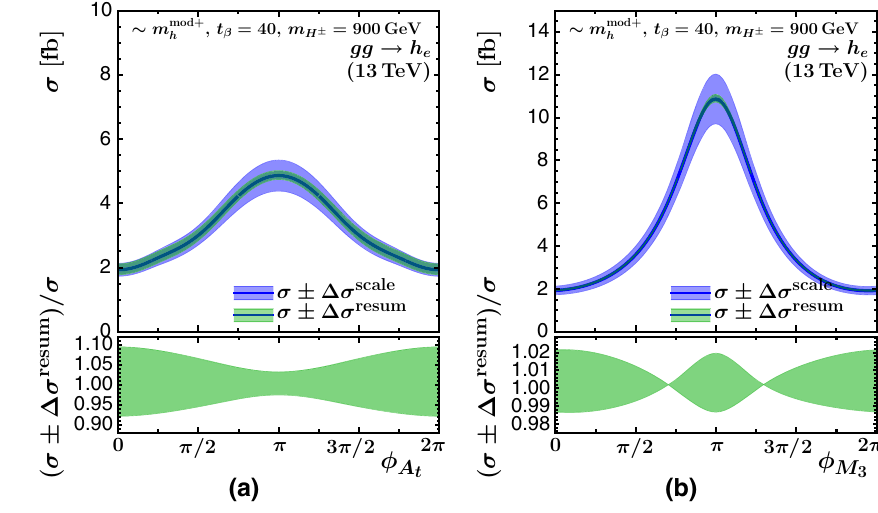
Fig. 12 Renormalisation and factorisation scale uncertainties (cid:8)σ scale ( blue ) and resummation uncertainties (cid:8)σ resum ( green ) for the gluon-fusion cross section of h e as a function of a φ φ A t and b M 3 in the m mod + -inspired scenario for h tan β = 40. In the lower panel the upper and lower edge of the band of the cross section prediction with the assigned resummation uncertainty is normalised to the cross section without this